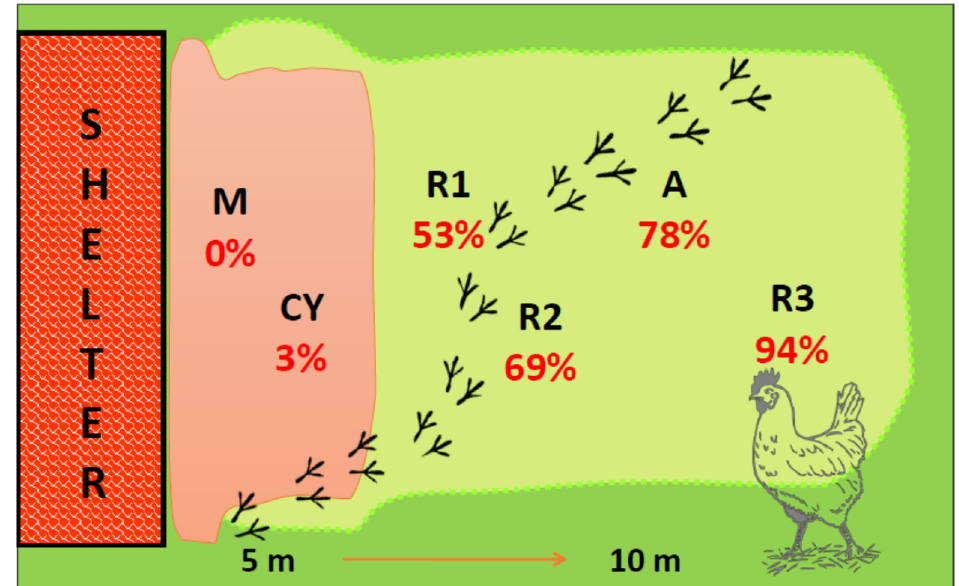
Figure 4. Schematic representation of outdoor run use by different poultry genotypes. (R1) Ranger Classic, (R2) Ranger Gold, (R3) Rowan Ranger, (A) Hubbard RedJA, (CY) Gen 5 × JA87, (M) M22 × JA87. In red percentage of time spent outdoor (respect of total opening time of shelter).